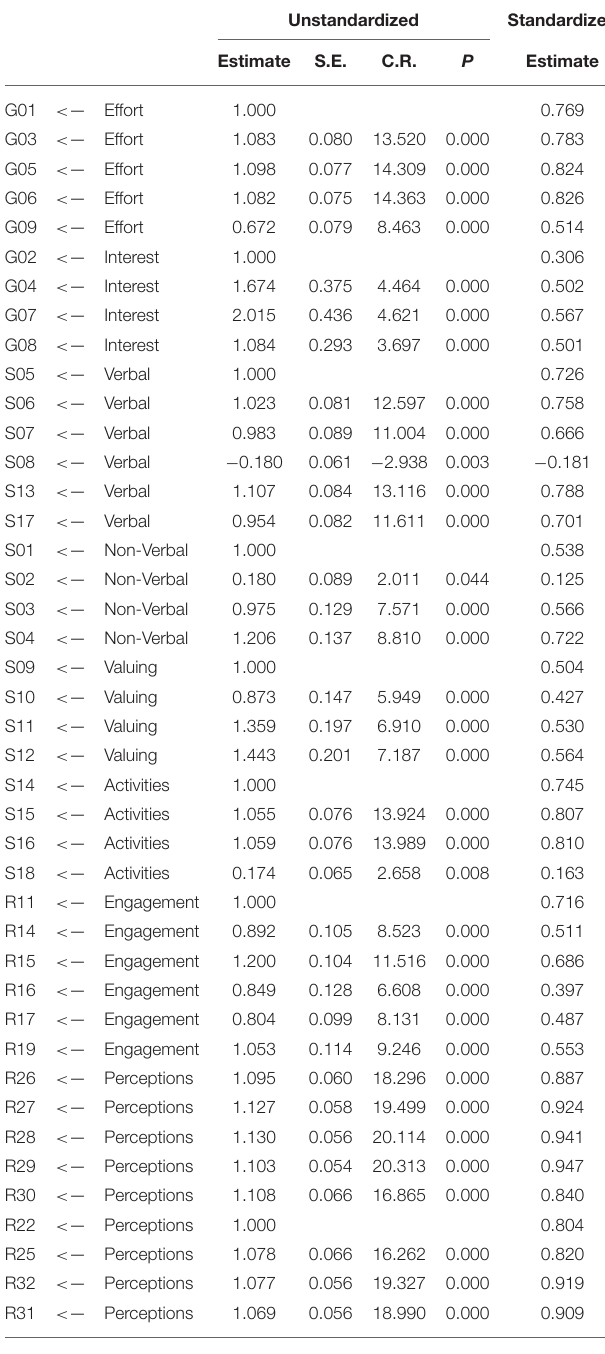
TABLE 1 | Unstandardized and standardize estimates of the initial CFA